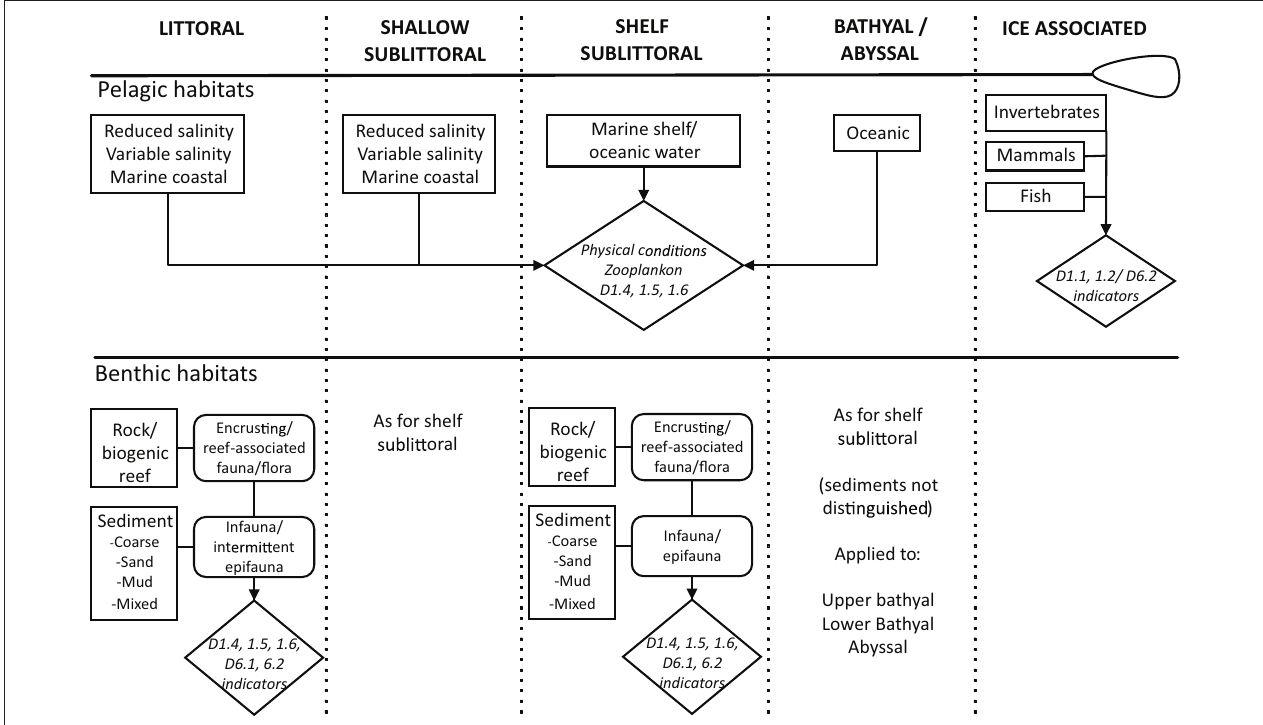
FIGURE 2 | Conceptual illustration of the biodiversity components associated with pelagic and seafloor habitats. Indicators in diamond-shaped boxes refer to Descriptors (D) and criteria (digits) of the MSFD (European Commission, 2010).